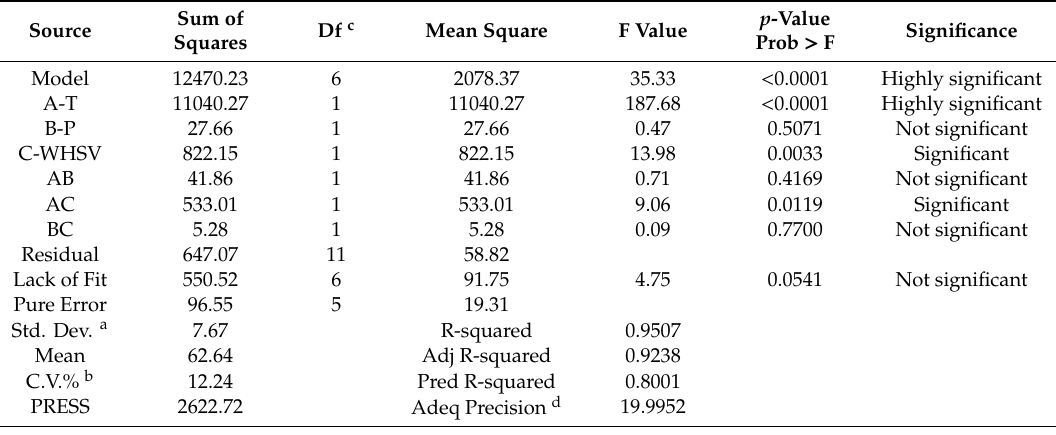
Table 2. Analysis of variance for the C2 = experimental response.